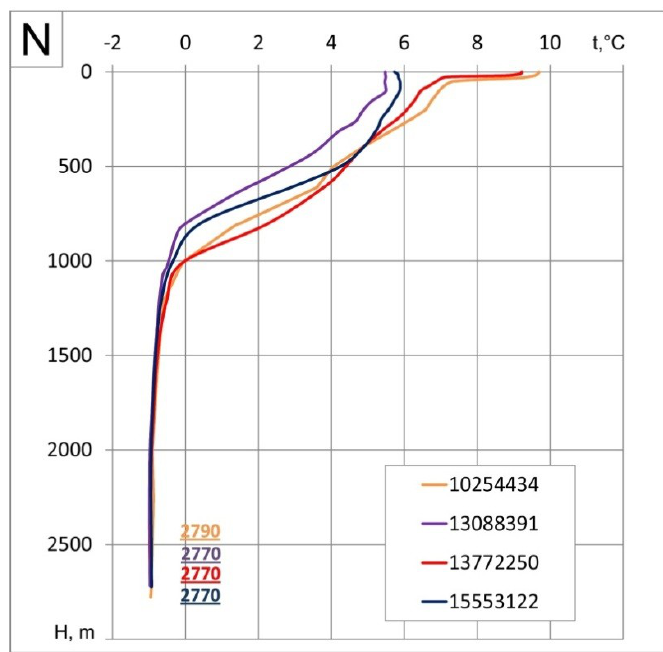
Figure 3. Plots of water temperatures for stations in the area N, demonstrated in Figure 2.